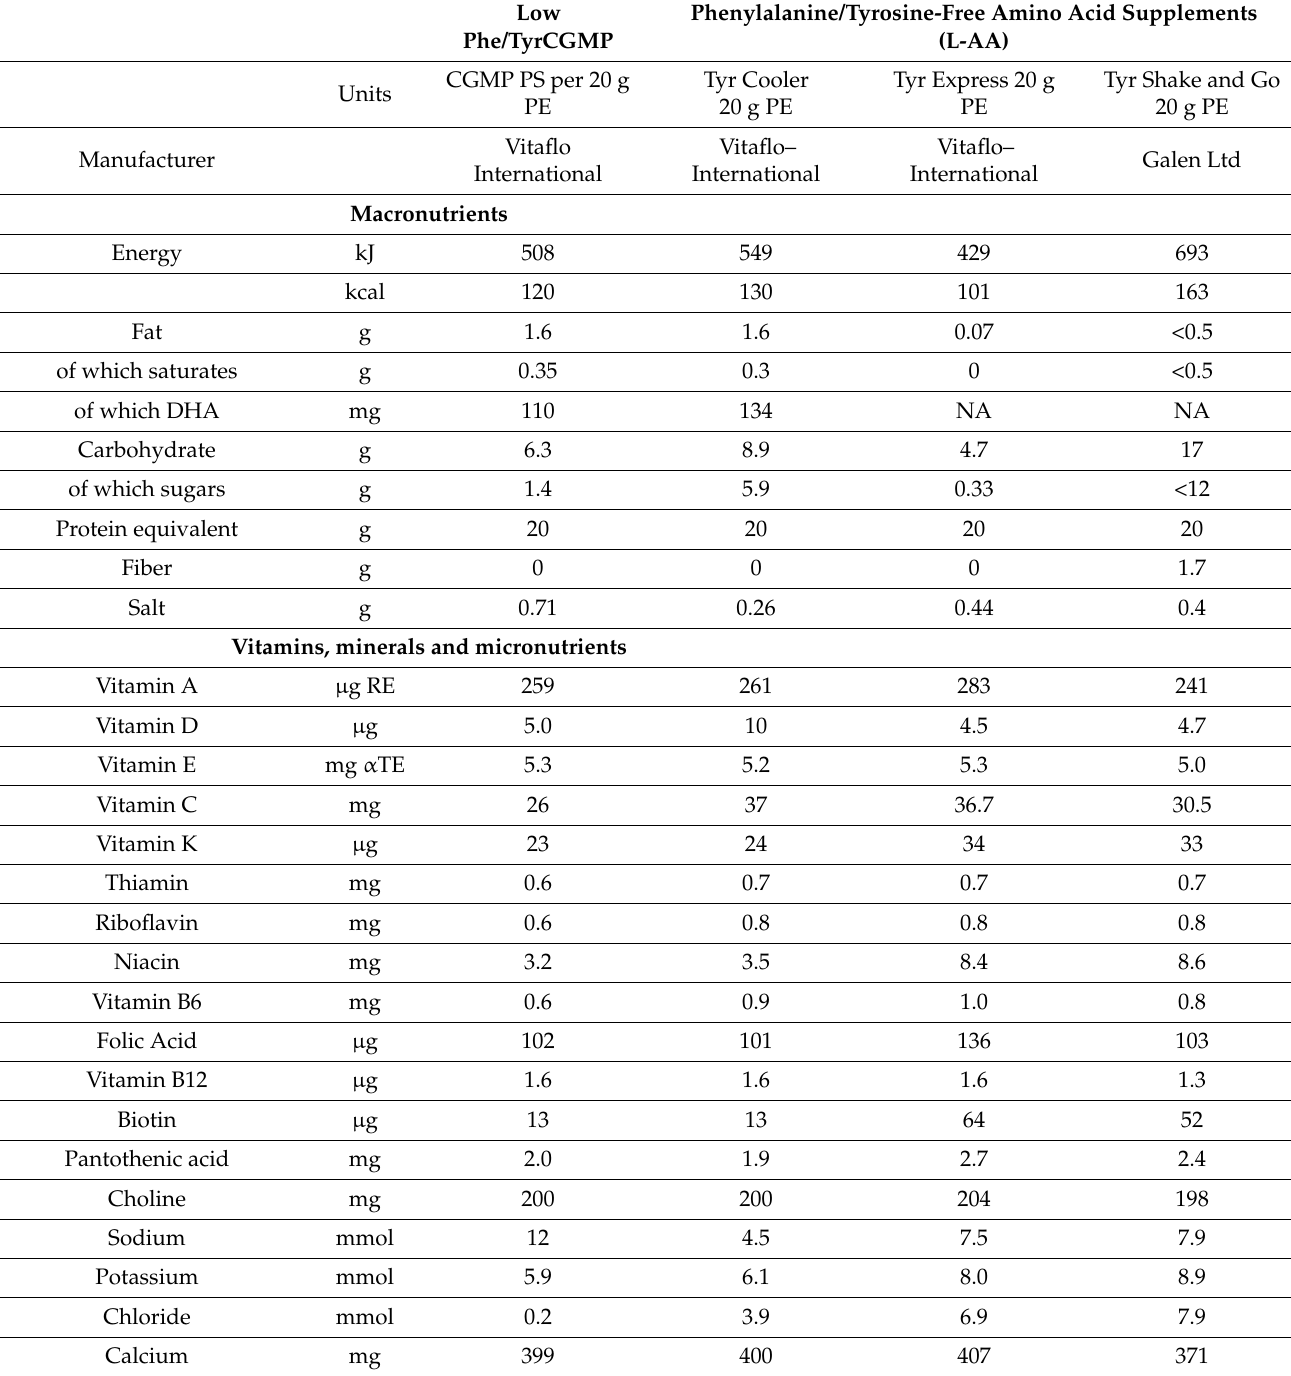
Table 1. Nutritional composition of protein substitutes for HTI used in the